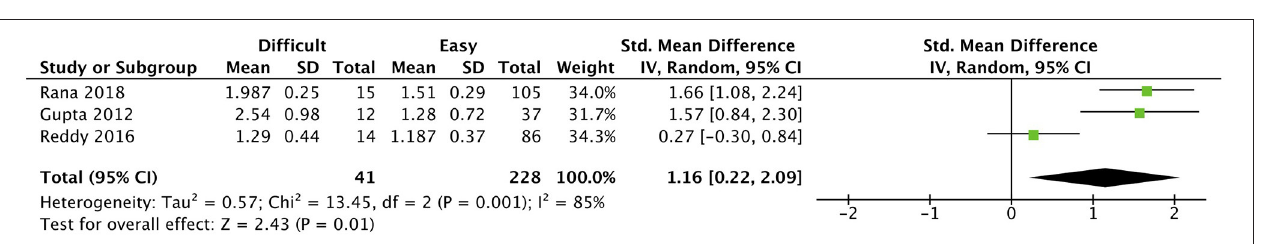
FIGURE 5 | Ratio between the pre-epiglottic space depth and the distance from epiglottis to the midpoint of the vocal cords (Pre-E/mVC) forest plot comparing difficult and easy laryngoscopy groups.